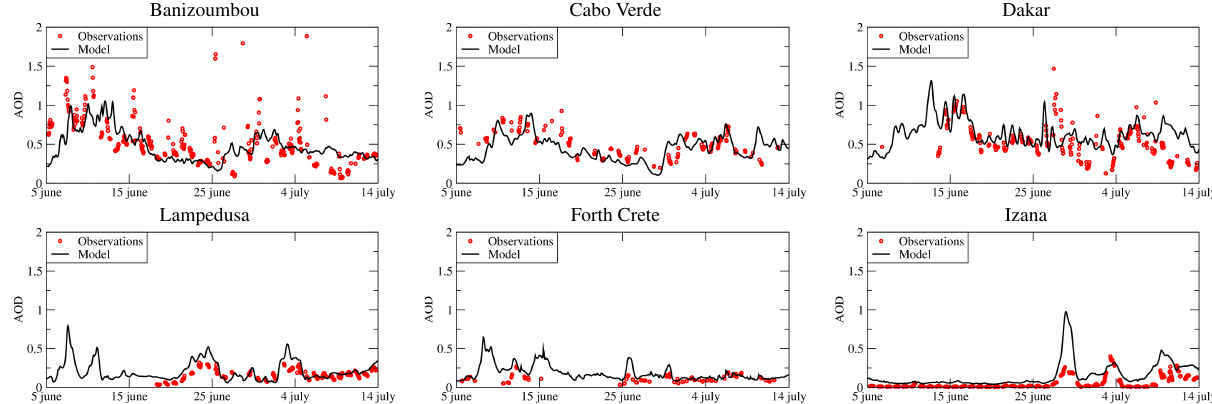
Figure 14. Time series of hourly AOD for selected AERONET stations.